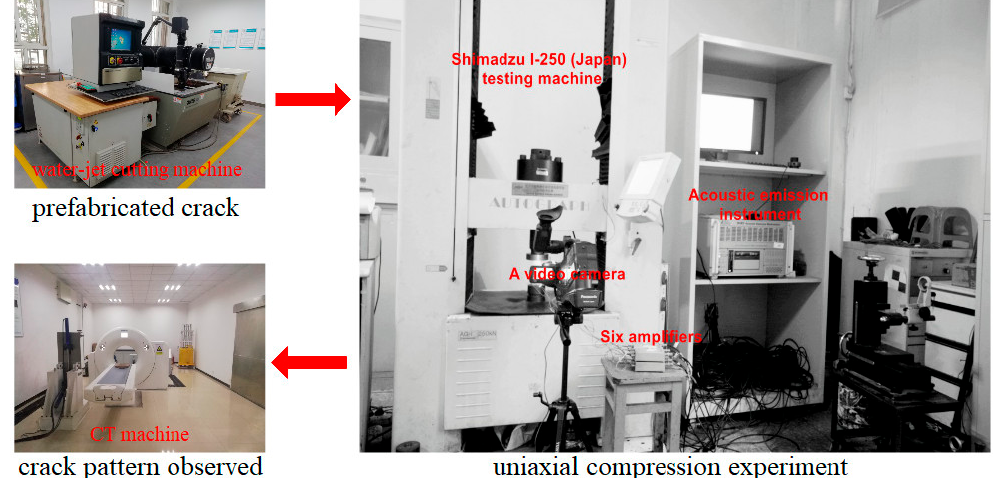
Figure 3. Experimental equipment and procedure.